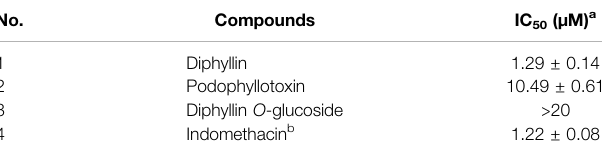
TABLE 2 | The IC 50 values of representative compounds screened from P. sinense against COX-2 in vitro .